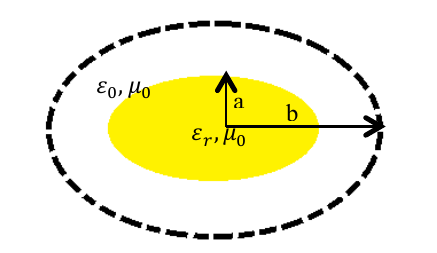
Figure 4: The schematic of our problem. The central ellip se is dielectric and the covering FSS is drawn by dash